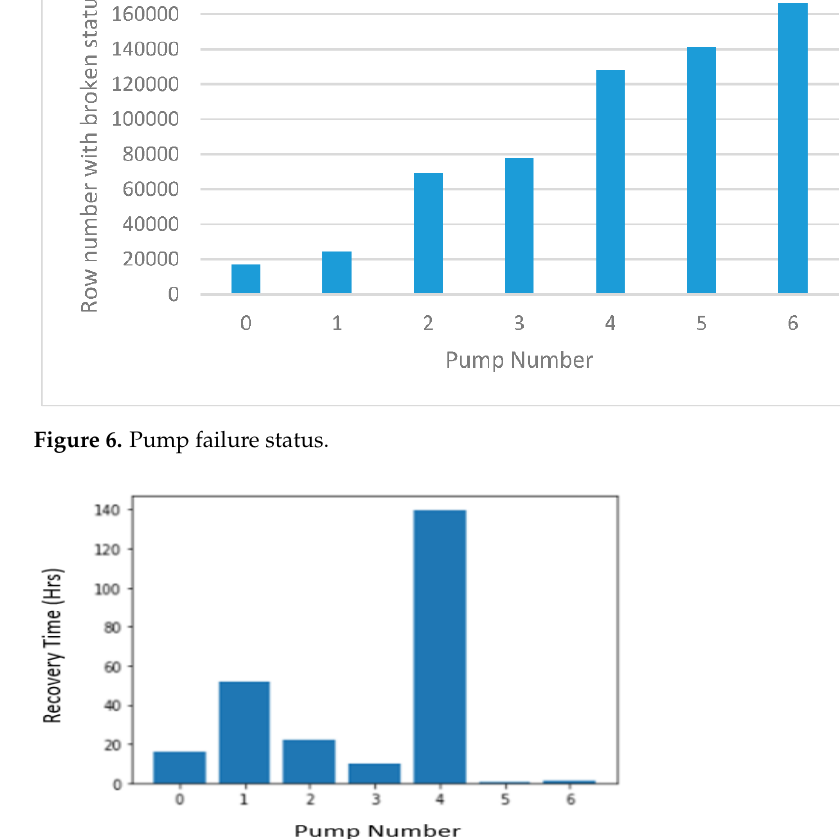
Figure 7. Duration of recovery phase for the 7 pump